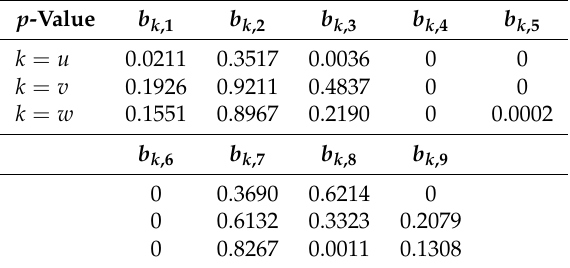
Table 9. Importance of variables in G k regression.